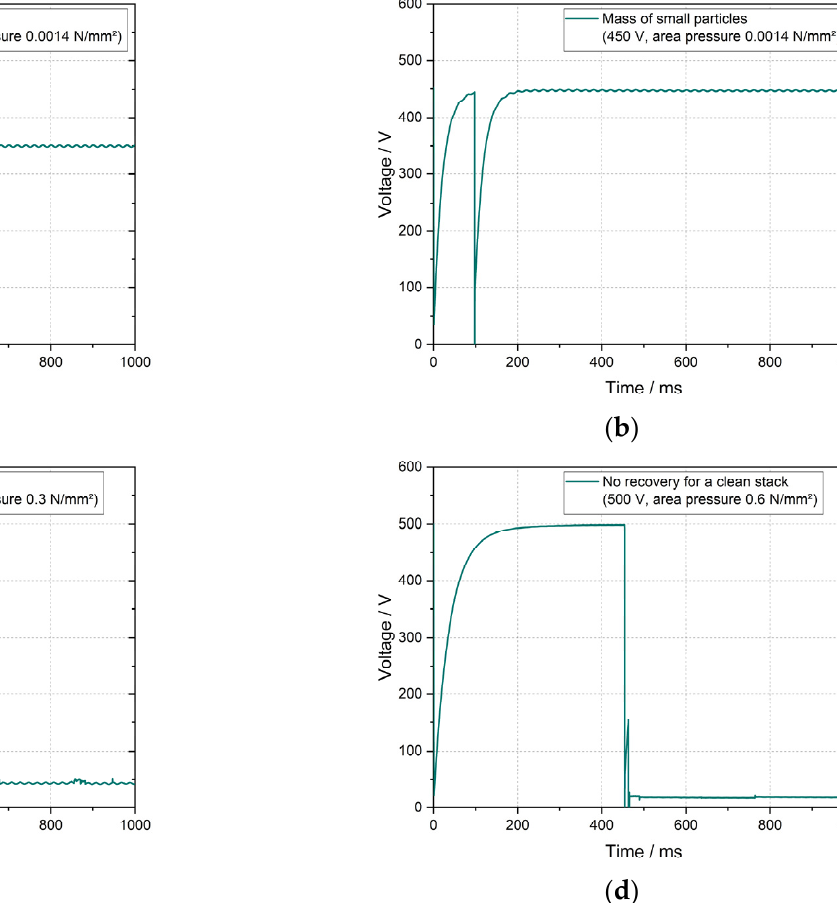
Figure 2. ( a ) behavior of a clean cell stack without discharge, ( b ) one discharge with full recovery for contamination with a mass of small particles, ( c ) several discharges with partial recoveries for contamination with one large particle, ( d ) discharge with no recovery for a clean cell stack. Adapted from Hoffmann et al. [19].